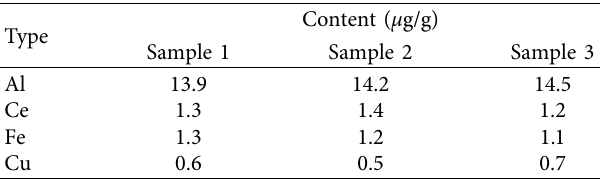
Table 1: Impurity content of three samples of fused silica optical surfaces.